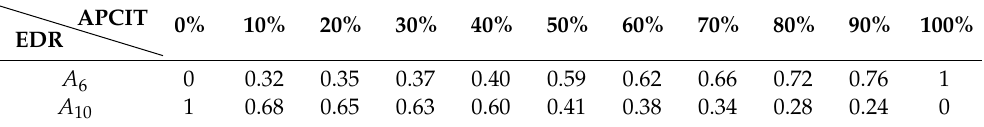
Table 3. EDR result of Move Mode